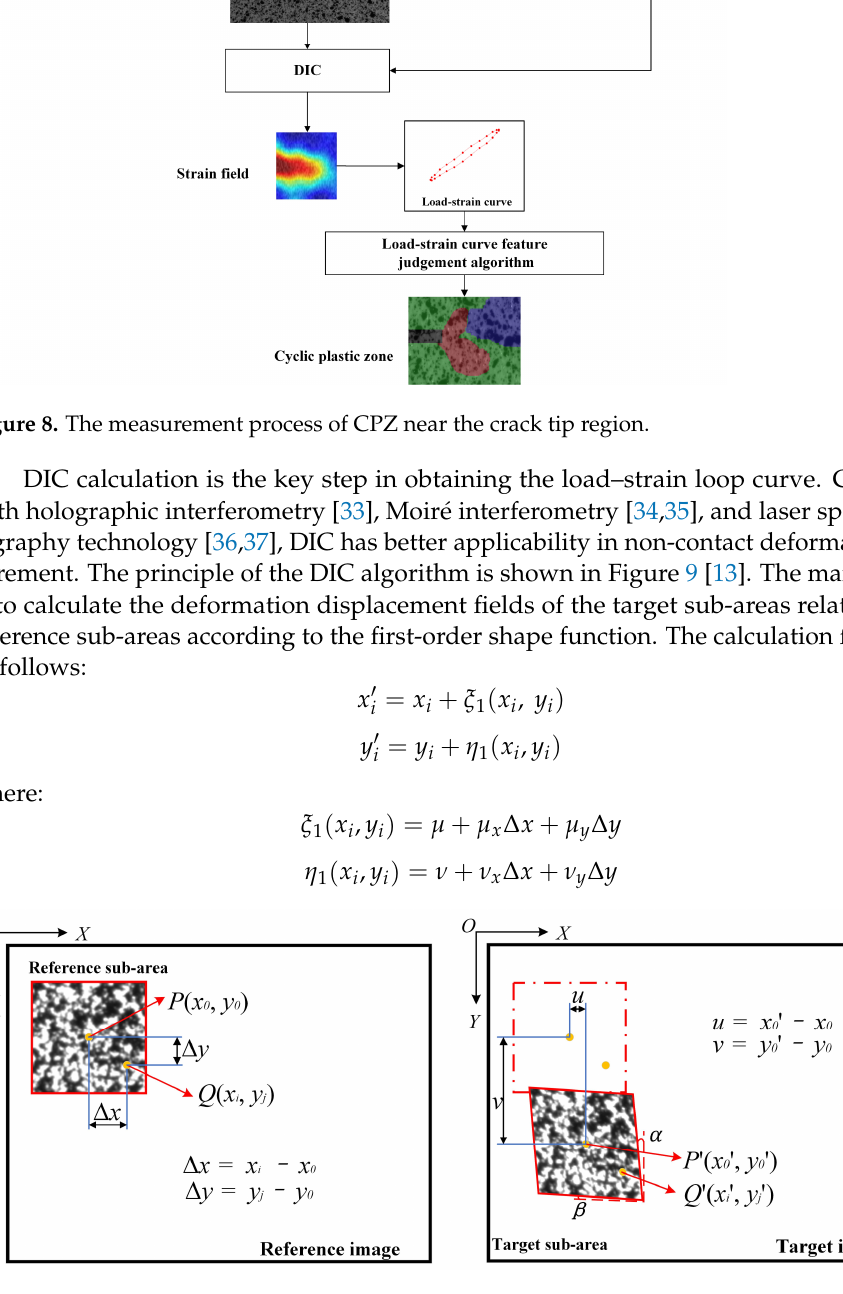
Figure 9. DIC calculation principle.